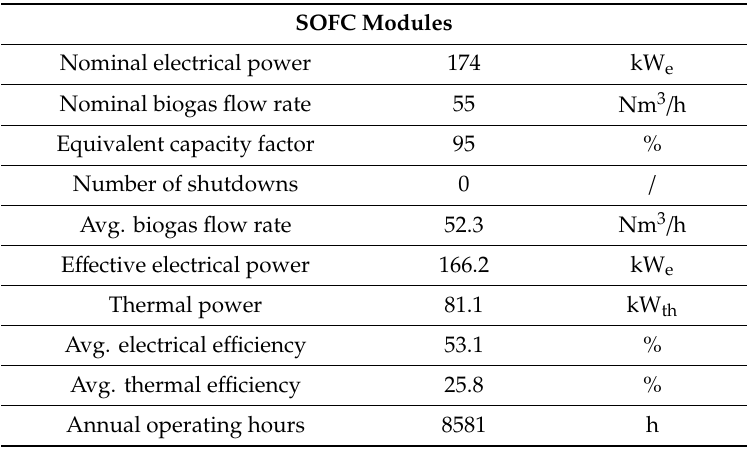
Table 7. SOFC modules, outputs of the energy planner tool [63].